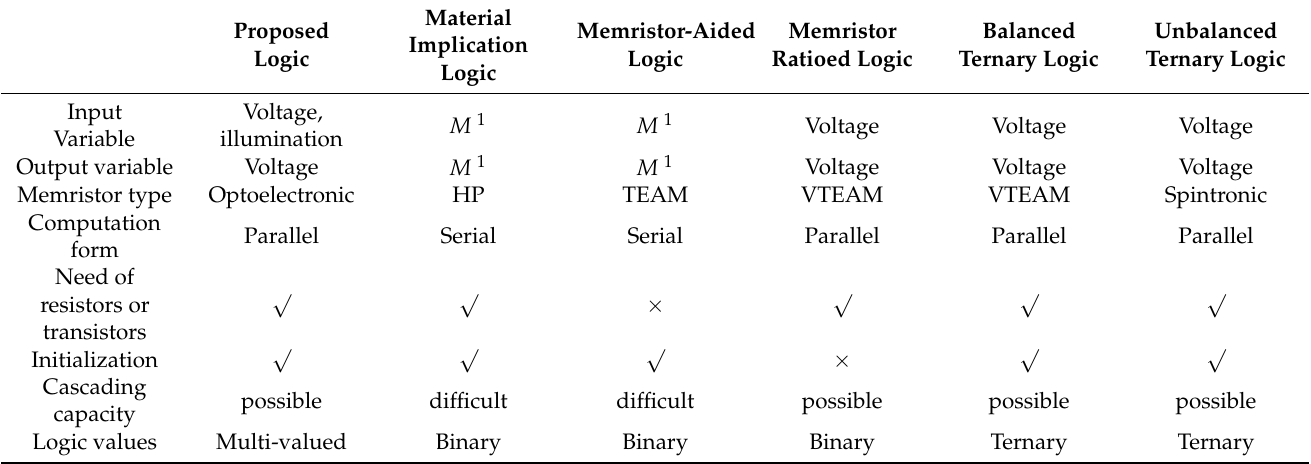
Table 5. Comparison results of the proposed multi-valued logic circuits with other logic